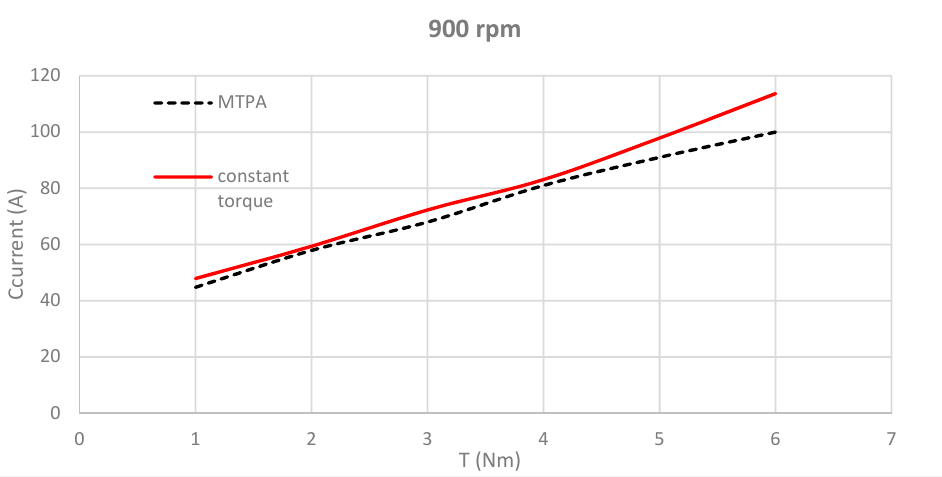
Figure 12. Curves of load vs current at 900 rpm using a fixed torque angle method and fuzzy MTPA control via HIL.